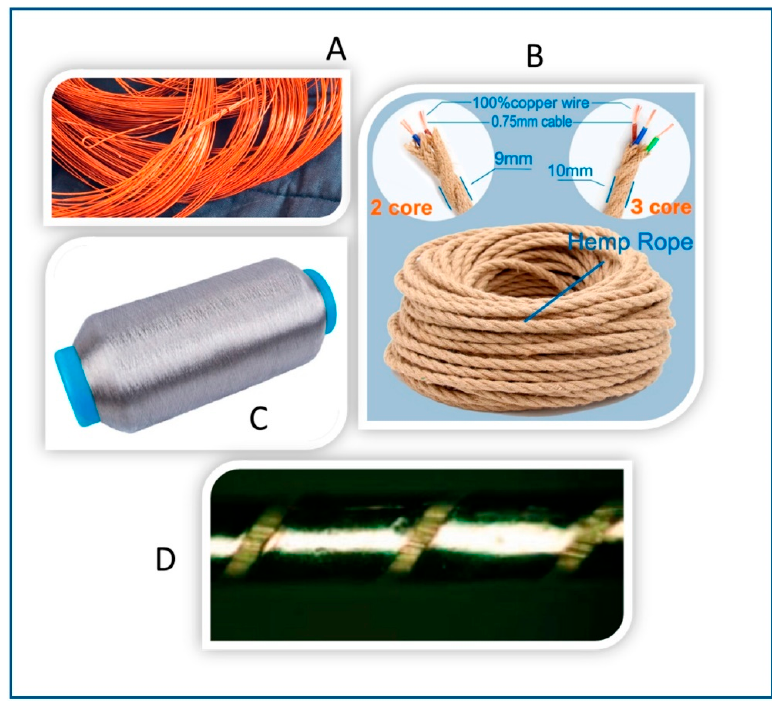
Figure 4. ( A ) Copper wire, ( B ) copper incorporated on hemp fiber, ( C ) silver-coated polyamide multifilament yarn, and ( D ) Kevlar multifilament yarn wrapped with metal foil. The images were taken from the Internet [47–50].